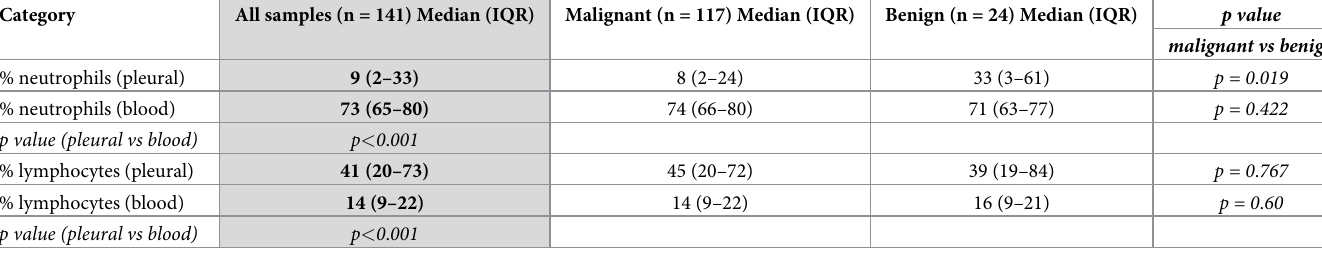
Table 2. Percentage of neutrophils and lymphocytes in pleural fluid and in blood.